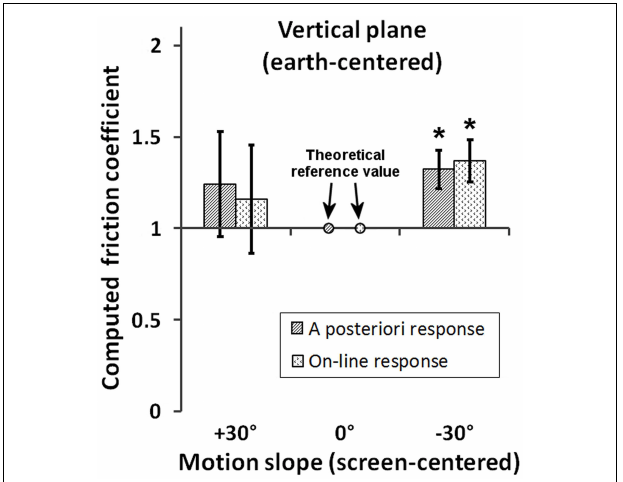
FIGURE 6 | Computed friction coefficients ( µ ) for each Response type condition (on-line vs. a posteriori) and Motion slope condition in the vertical Motion plane with implied friction. The theoretical reference value was set to µ = 1 for objects traveling along a 0 ◦ Motion slope visible surface. Stars indicate significant departure from the theoretical value after Bonferroni